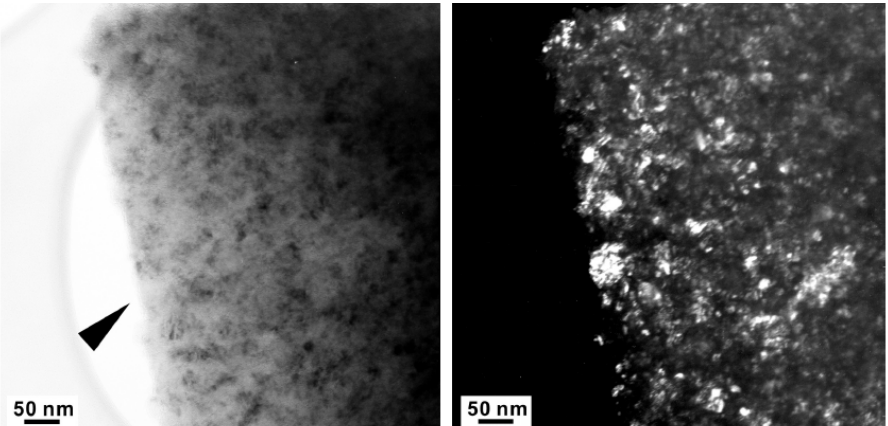
Figure 7. Bright field (BF) (left) and dark field (DF) (right) images of sample S4306 showing nano-sized polycrystalline material.